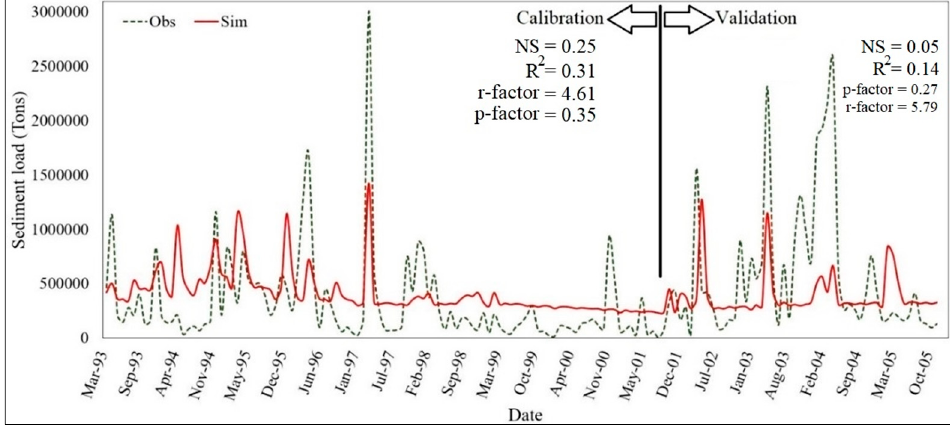
Figure 5. Calibration (1993–2005) and validation (2006–2014) of monthly streamflow in Harmaleh station.